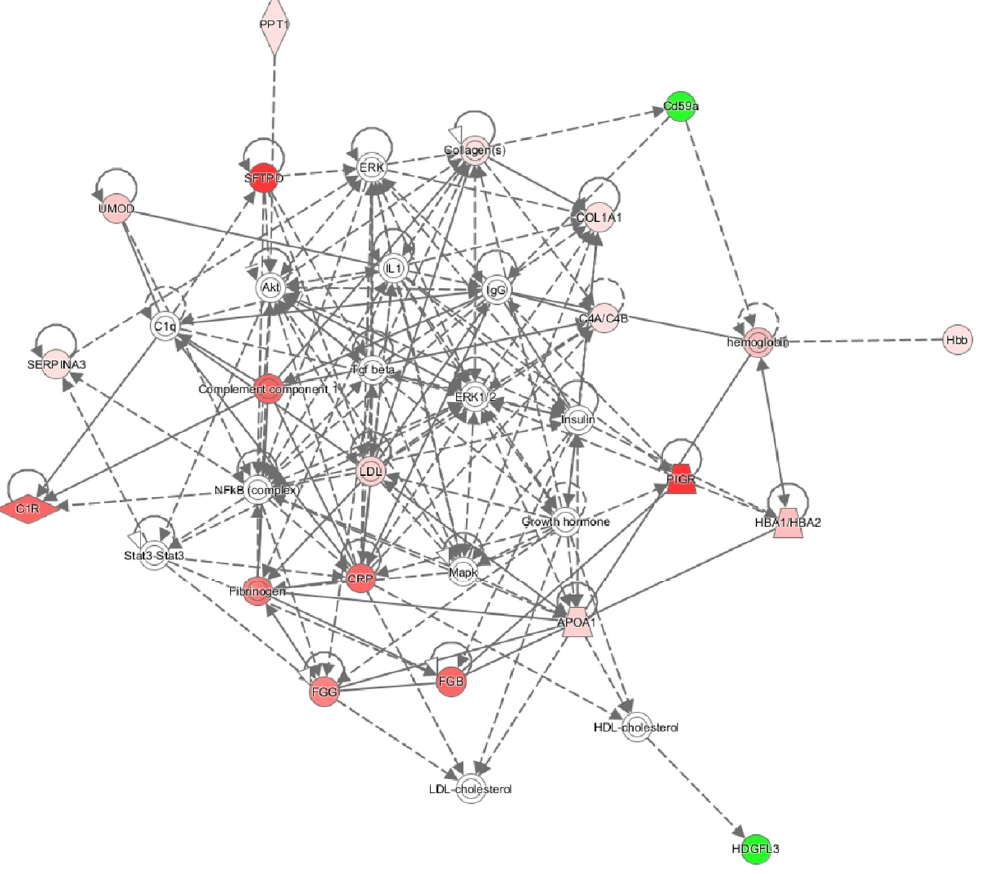
Figure 3. Network of the most strongly dysregulated proteins of the glomerular ECM in FSGS. The dysregulated genes from Table 1 and their interaction were analyzed by Ingenuity Pathway Analysis (red: downregulated; green: upregulated; stronger color means stronger regulation).